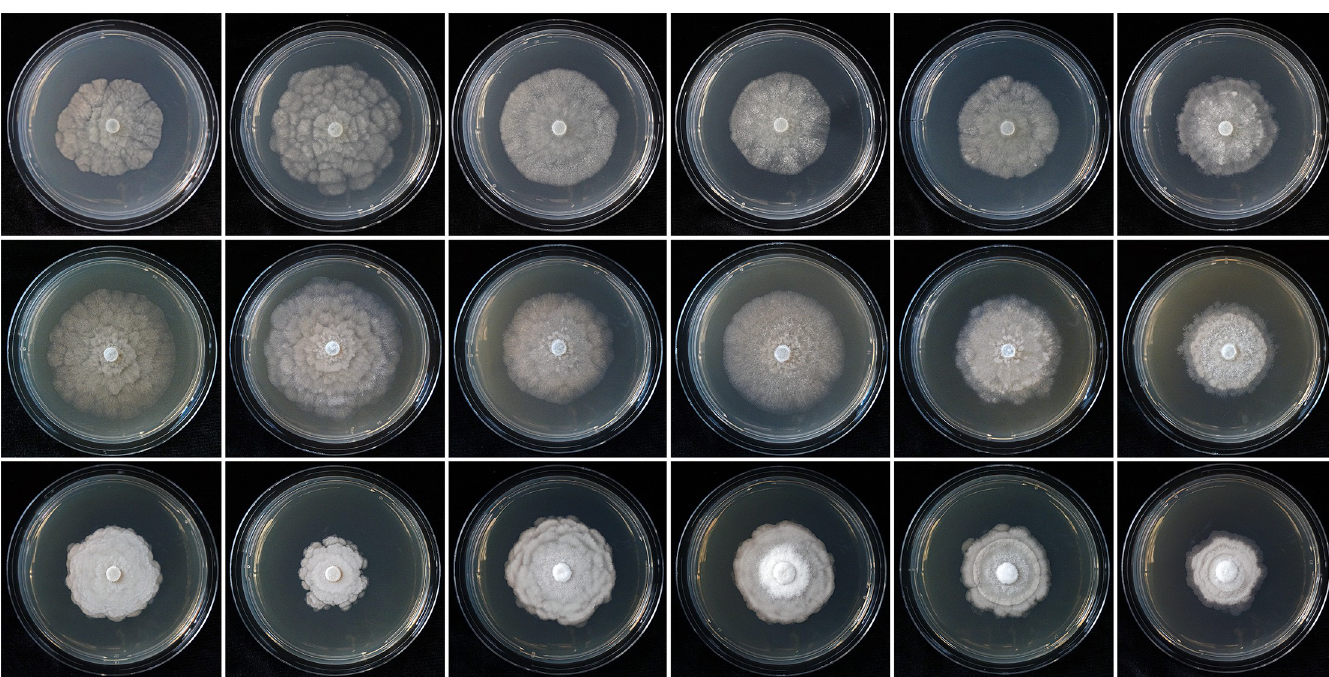
Fig 5. Colony morphology of Nothophytophthora irlandica isolates CBS 147242 and P17-76, and Nothophytophthora lirii isolates CBS 147244, P18-105, P18-27A and P18-99B (from left to right) after 14 d growth at 20˚C on V8 agar, carrot agar and potato-dextrose agar (from top to